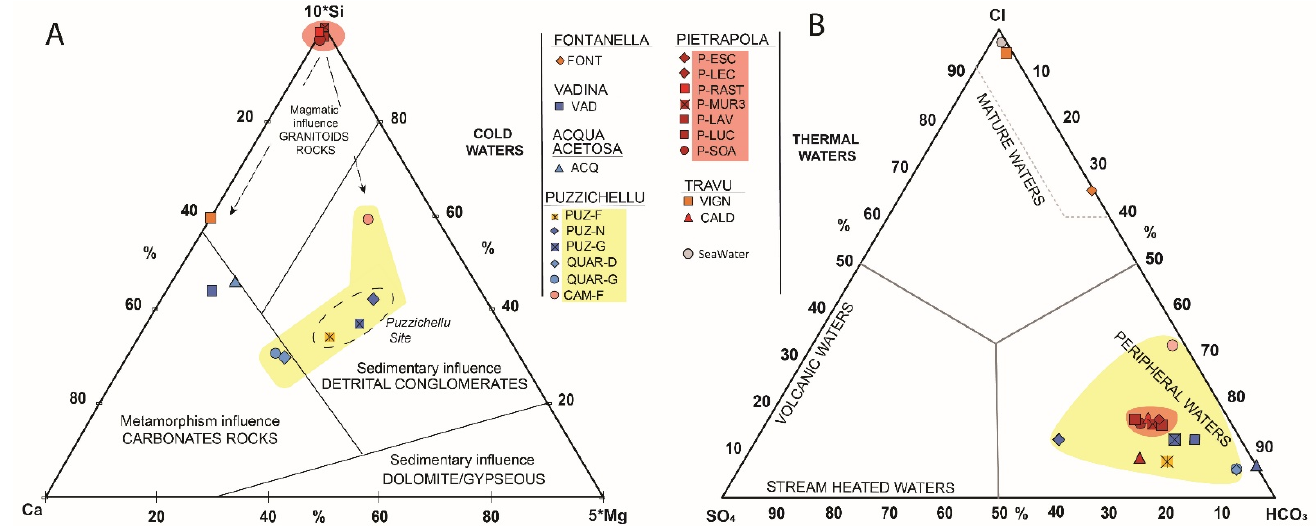
Figure 4. Ternary diagram displaying groundwater chemical content (SO 4 , Cl, Ca, Mg, Si and HCO 3 ). The spring group of Pietrapola is displayed in red background while Puzzichellu is displayed in yellow background. The ternary ( A ) displays the main lithology involved in water mineralisation. Indeed, this [Ca-5*Mg-10*Si] diagram is usually used to illustrate the lithology of rocks involved in water–rock interactions [52,53]. Due to the absence of Si value, FONT and CALD are not displayed on this plot. Developed by Giggenbach [54], the ( B ) ternary diagram helps discerning mature and peripheral waters and gives crucial information about fluid mixing.